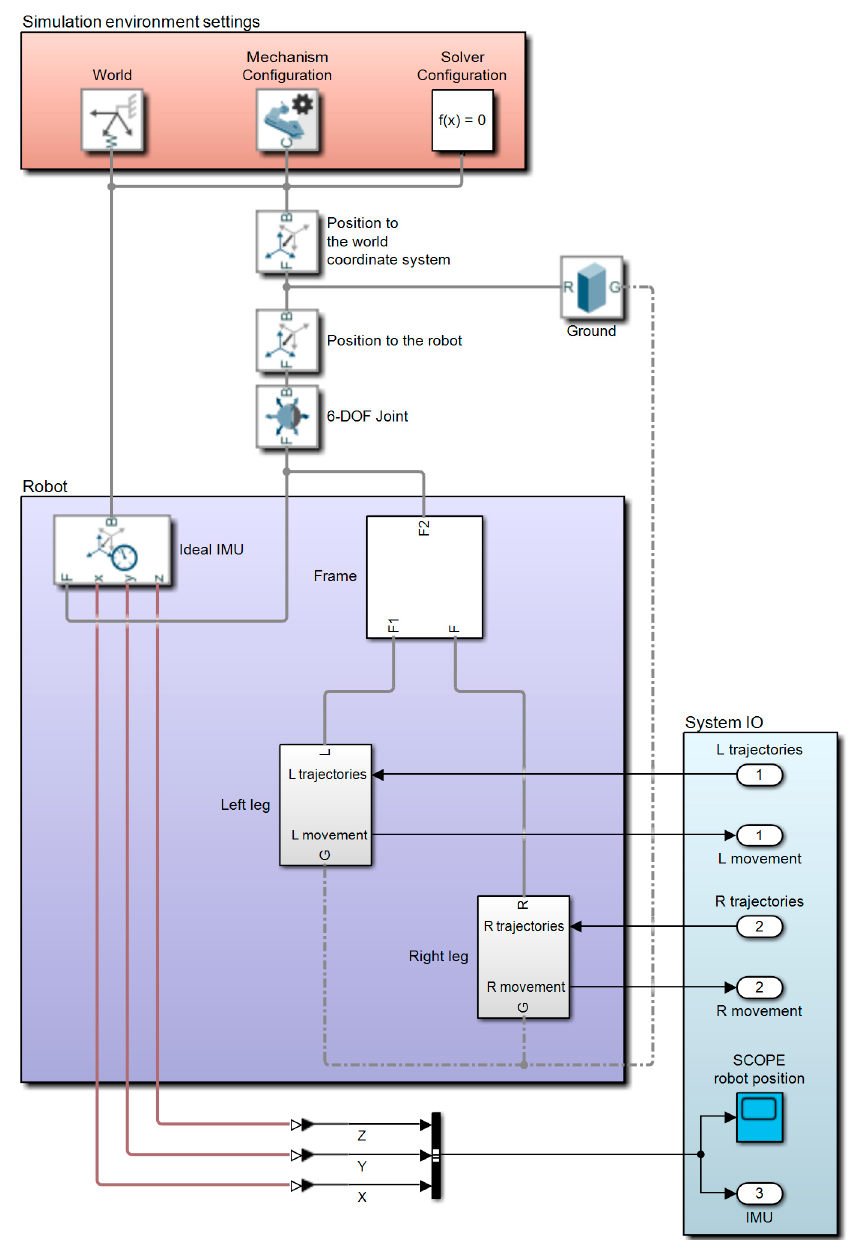
Figure 10. Simulation model of bipedal robot walking.